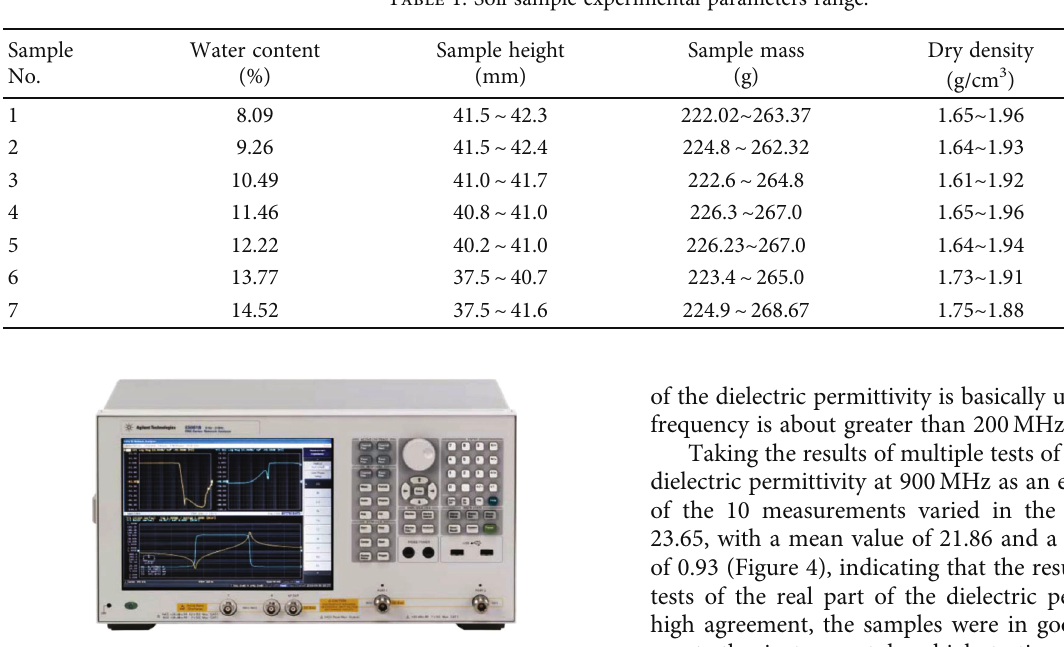
Table 1: Soil sample experimental parameters range.